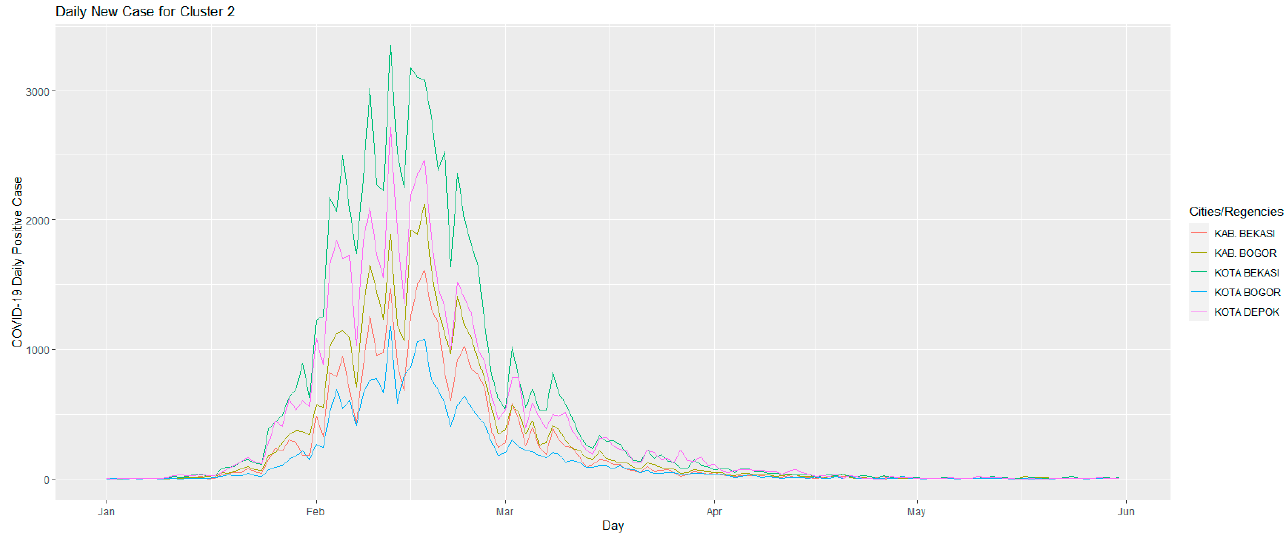
Figure 9. Daily positive cases of COVID-19 in Cluster 2 for the second period.